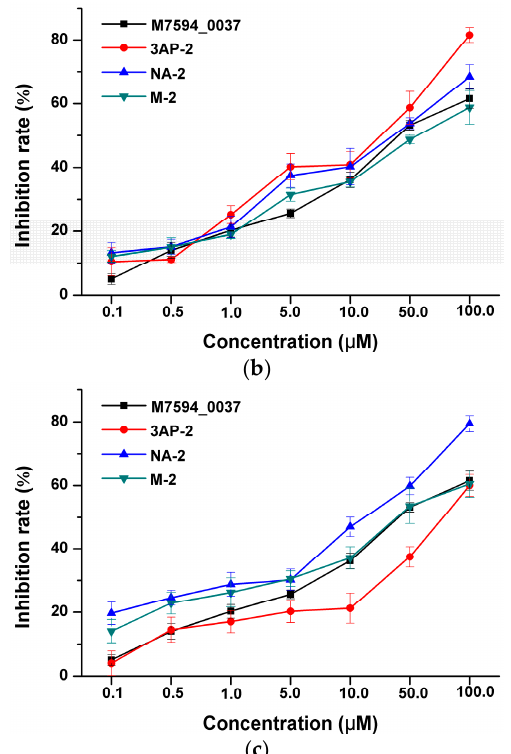
Figure 2. Inhibition rate of M7594_0037 and analogs against A549 ( a ), MCF7 ( b ) and HeLa ( c ) in dose-dependence. Table 1. Effect (IC 50 ) of M7594_0037 and analogs on human cancer cell lines.